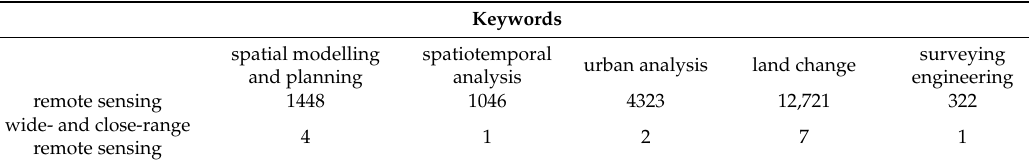
Table 1. The number of related papers following the query (on 19 November